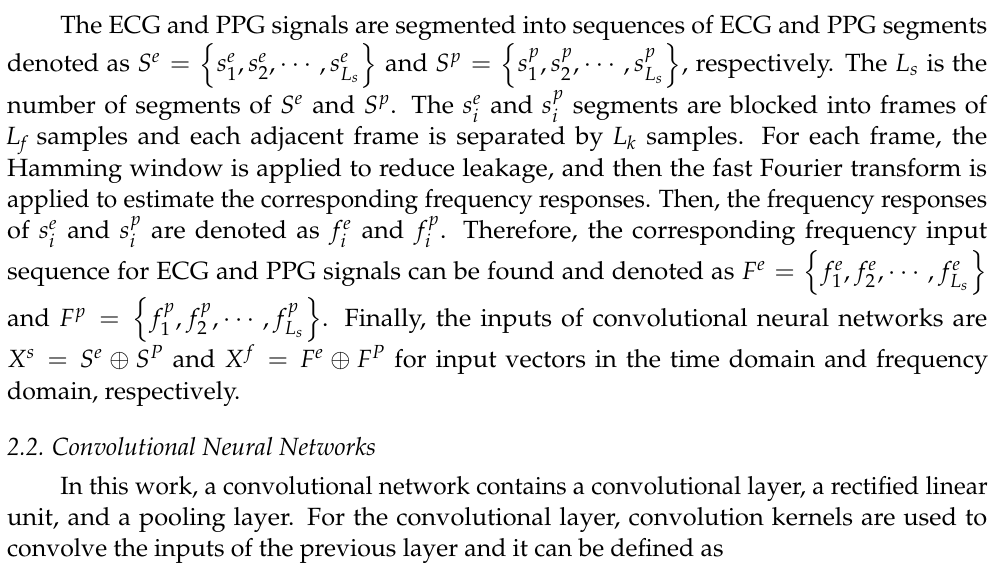
Figure 1. Network structure of the proposed attention mechanism-based CNN-LSTM.